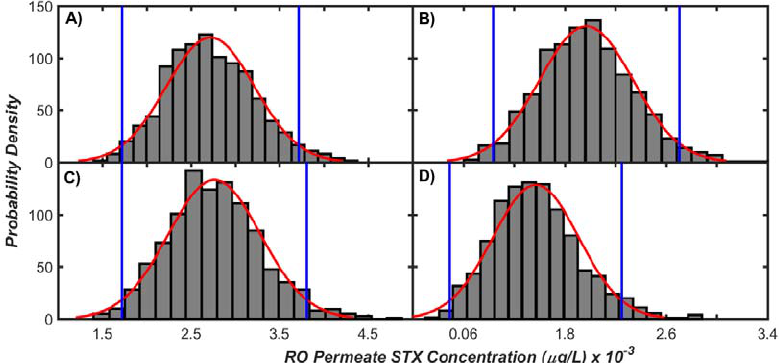
Figure 2. STX toxin concentrations in the RO permeate for: ( a ) GMF processes without coagulation ( T8 ), ( b ) Pressurized MF/UF processes without coagulation ( T9 ), ( c ) GMF processes with coagulation ( T6 ), and ( d ) Pressurized MF/UF processes with coagulation ( T4 ).